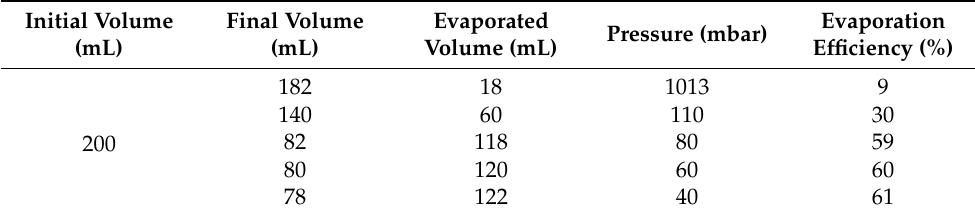
Table A1. Water evaporation trial in 1 h with a rotary vacuum